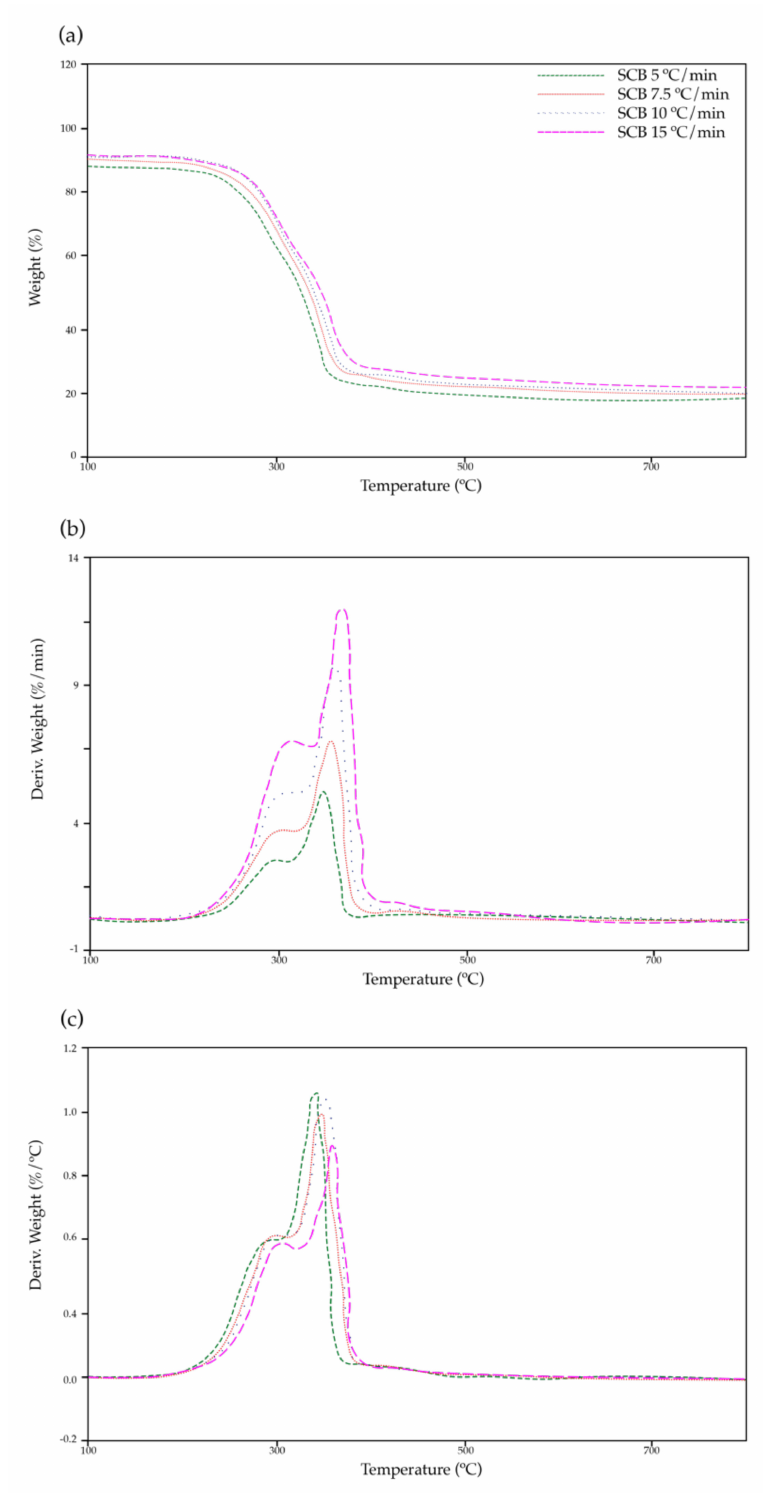
Figure 2. ( a ) Distribution of TG; ( b ) DTG in terms of % · min − 1 ; and ( c ) DTG in terms of % · ◦ C − 1 of SCB at four heating